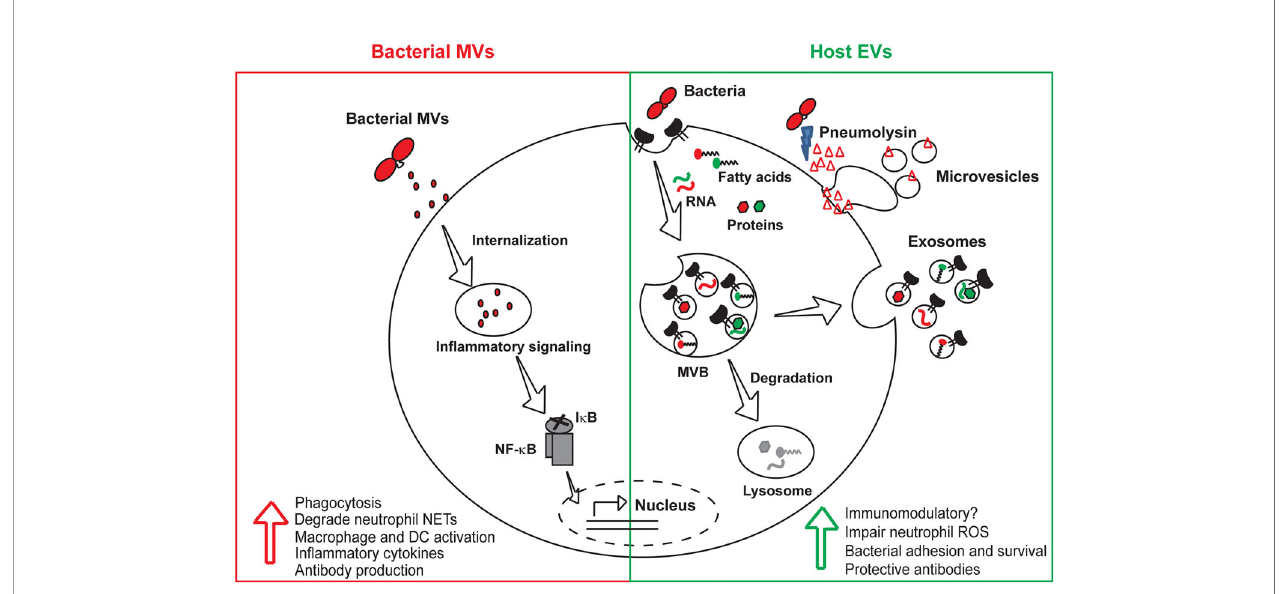
FIGURE 1 | Roles of bacterial and host vesicles in pneumococcal infections. Both bacterial and host-derived vesicles are released during infection. Bacterial MVs containing virulence factors and toxins are internalized by host cells, activate macrophages and dendritic cells resulting in the production of in fl ammatory cytokines and protective antibodies. Host EVs majorly consist of exosomes derived from exocytosis of multivesicular bodies and microvesicles that directly pinch off from the cell membrane. EVs released from infected host cells harbor bacterial and host macromolecules such as RNA, fatty acids and proteins, that enhance bacterial invasion and intracellular survival by transmitting virulence factors to bystander cells. Pores induced by the pore-forming toxin, pneumolysin are extruded as microvesicles during the process of eukaryotic cell membrane repair. The immunomodulatory role of host EVs is unclear and needs to be further investigated. EVs, host extracellular vesicles; MVs, bacterial membrane vesicles; MVB, multivesicular body; NF- k B, nuclear factor k B; I k B, inhibitor k B; DC, dendritic